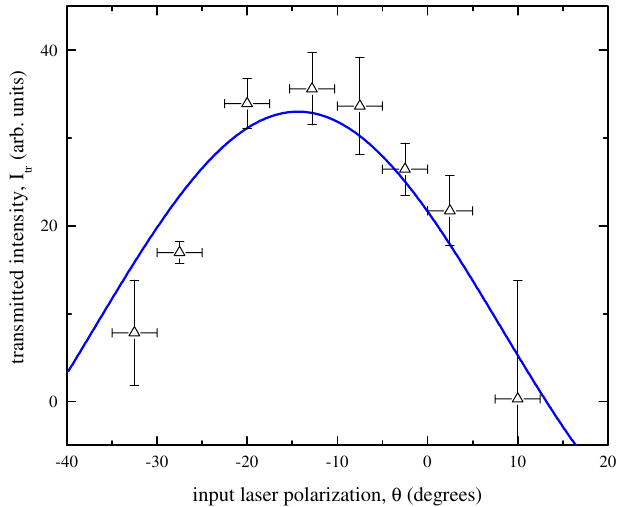
FIG. 6. (Color) EOS transmitted intensity as a function of input laser polarization angle. The maximum signal occurs at (cid:5) (cid:1) (cid:4) 17 (cid:2) . A sin 2 fit (solid line) is used to guide the